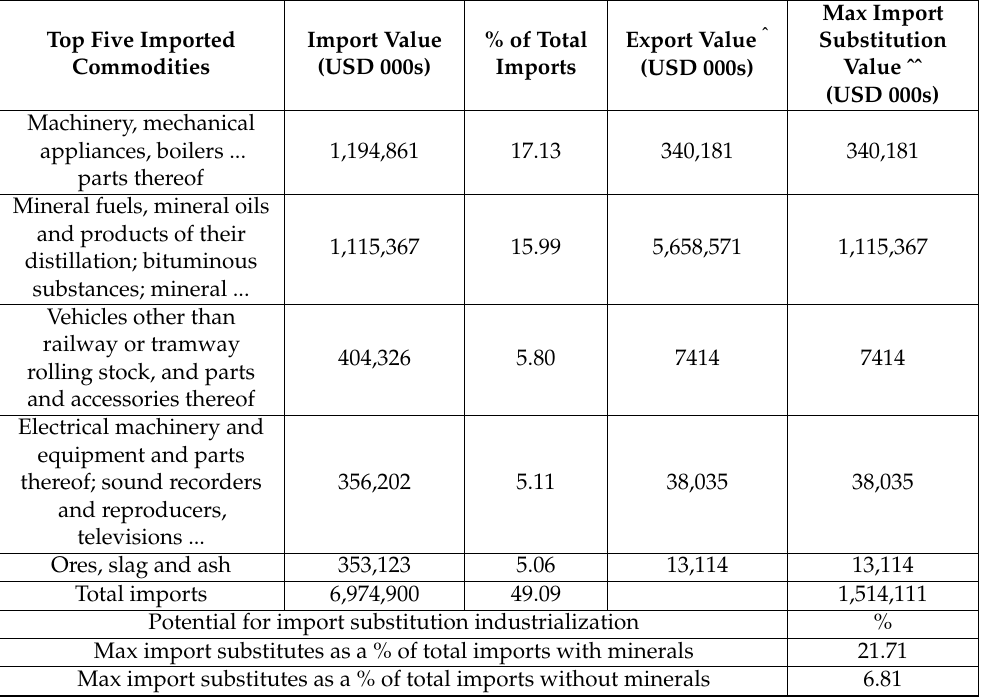
Table 4. Potential for import substitution industrialization for T&T for